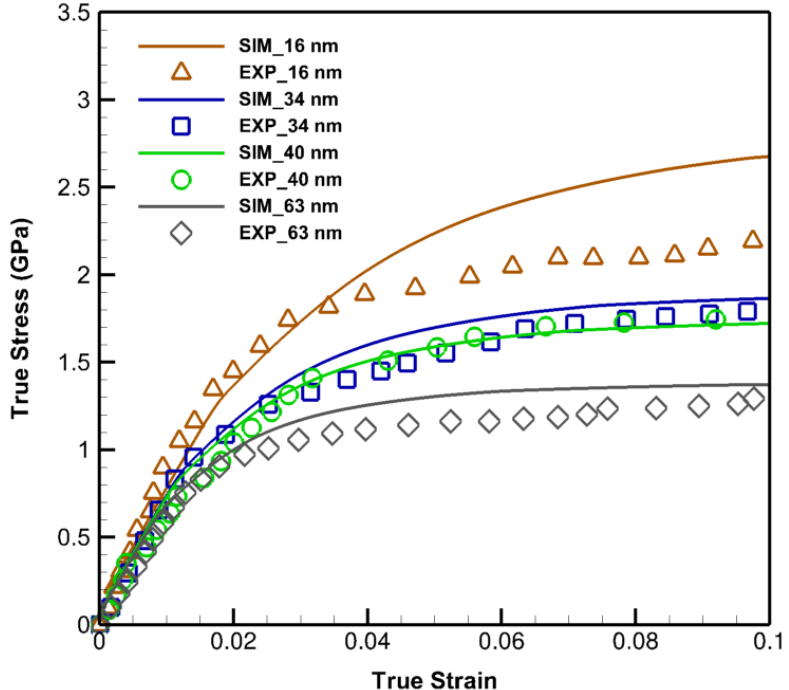
Figure 4. The verification of the size-dependent constitutive model and deep-learning SLC results plotted by “SIM” and solid lines with the experimental data [49,50] designated by “EXP” and symbolic